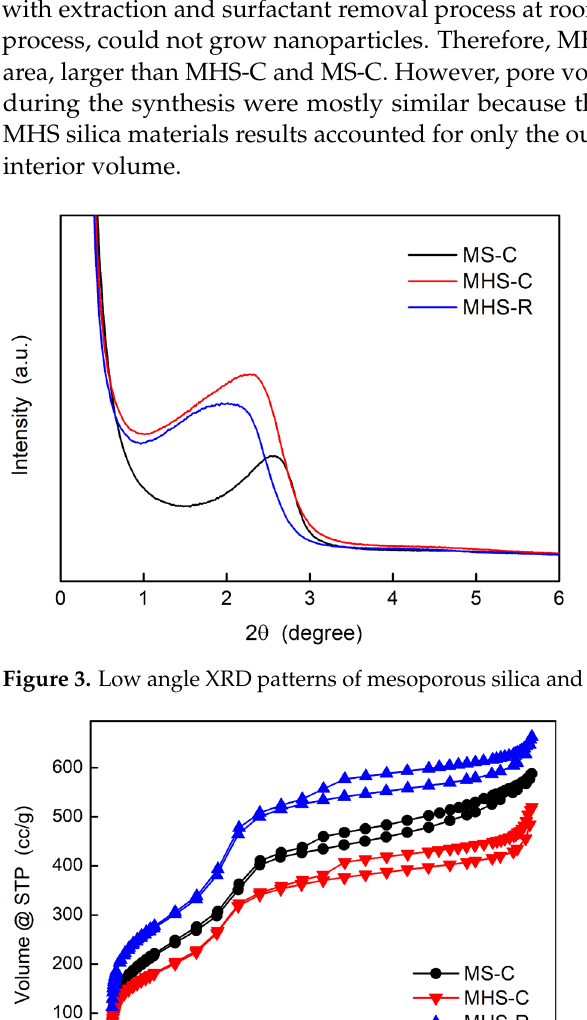
Figure 4. N 2 -adsorption-desorption isotherm graphs of mesoporous silica and mesoporous hollow silica materials. Table 1. Textural properties of mesoporous silica and mesoporous hollow